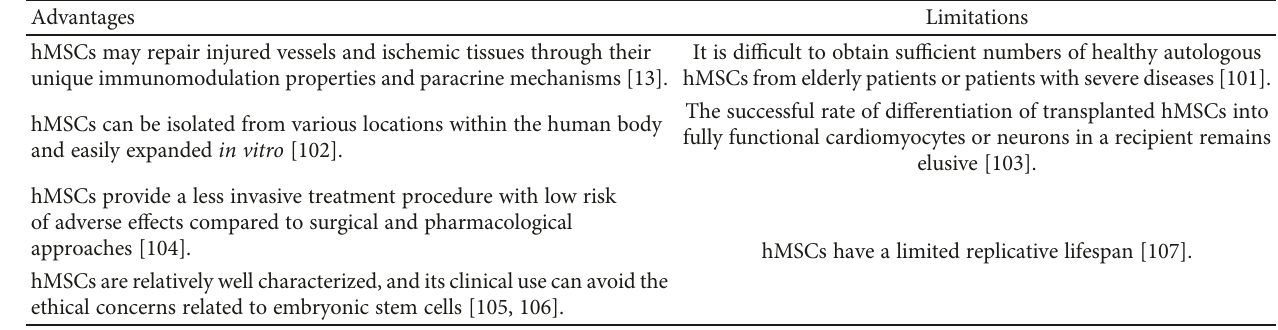
Table 1: The advantages and limitations of hMSCs for the treatment of ischemic